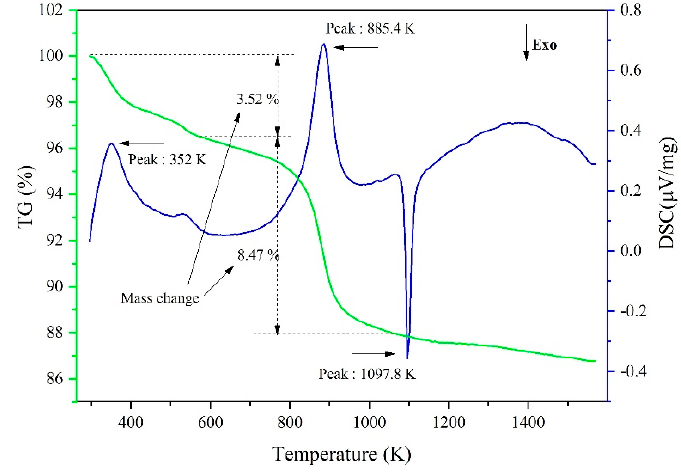
Figure 11. Thermogravimetry-differential scanning calorimetry (TG and DSC) curves of the raw materials.